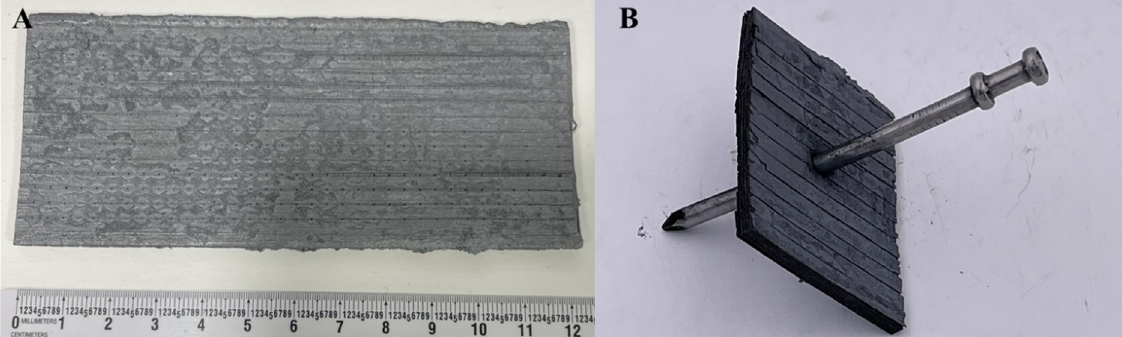
Figure 5. Images of ( A ) fully processed C/C-SiC panel and ( B ) C/C-SiC panel after the nail impact toughness test, demonstrating qualitative toughness.